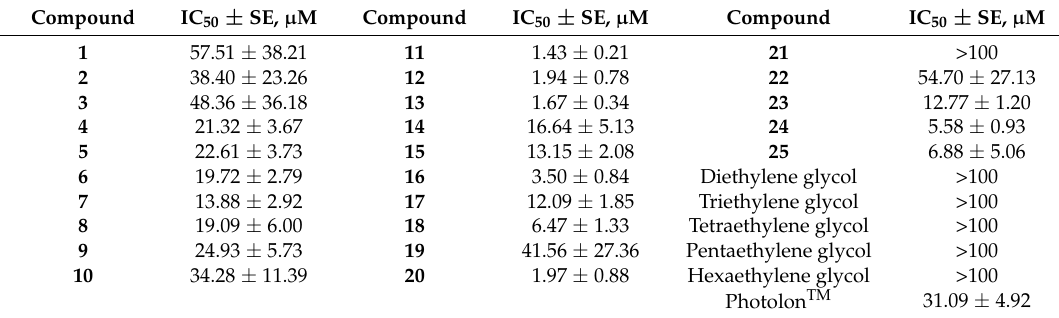
Table 1. Dark cytotoxic activity of chlorophyll-a derivatives and oligoethylene glycols on HeLa cells. Compound IC 50 ± SE, µ M Compound IC 50 ± SE, µ